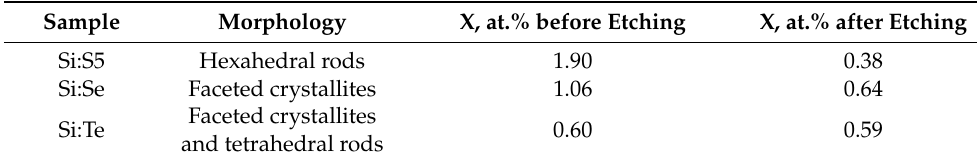
Table 2. Results of annealing in the presence of 20 at.% of S, Se and Te (X stands for chalcogen).